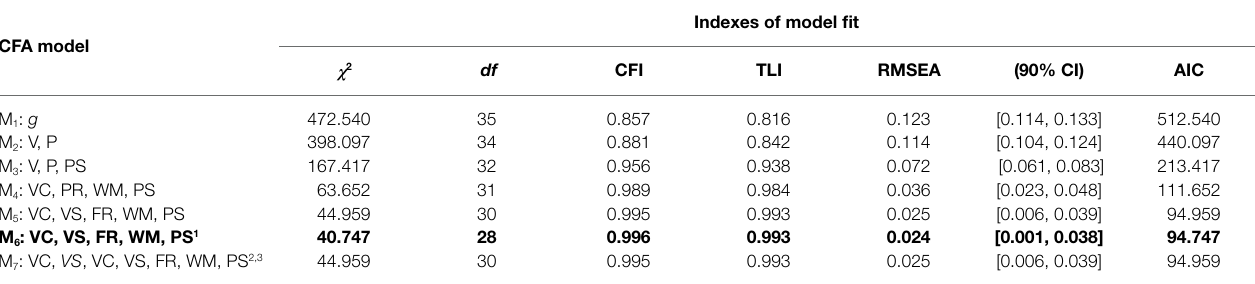
TABLE 6 | Maximum likelihood estimation and model fit statistics based on the 10 WISC-V primary subtests for the CFA sample ( n = 823).